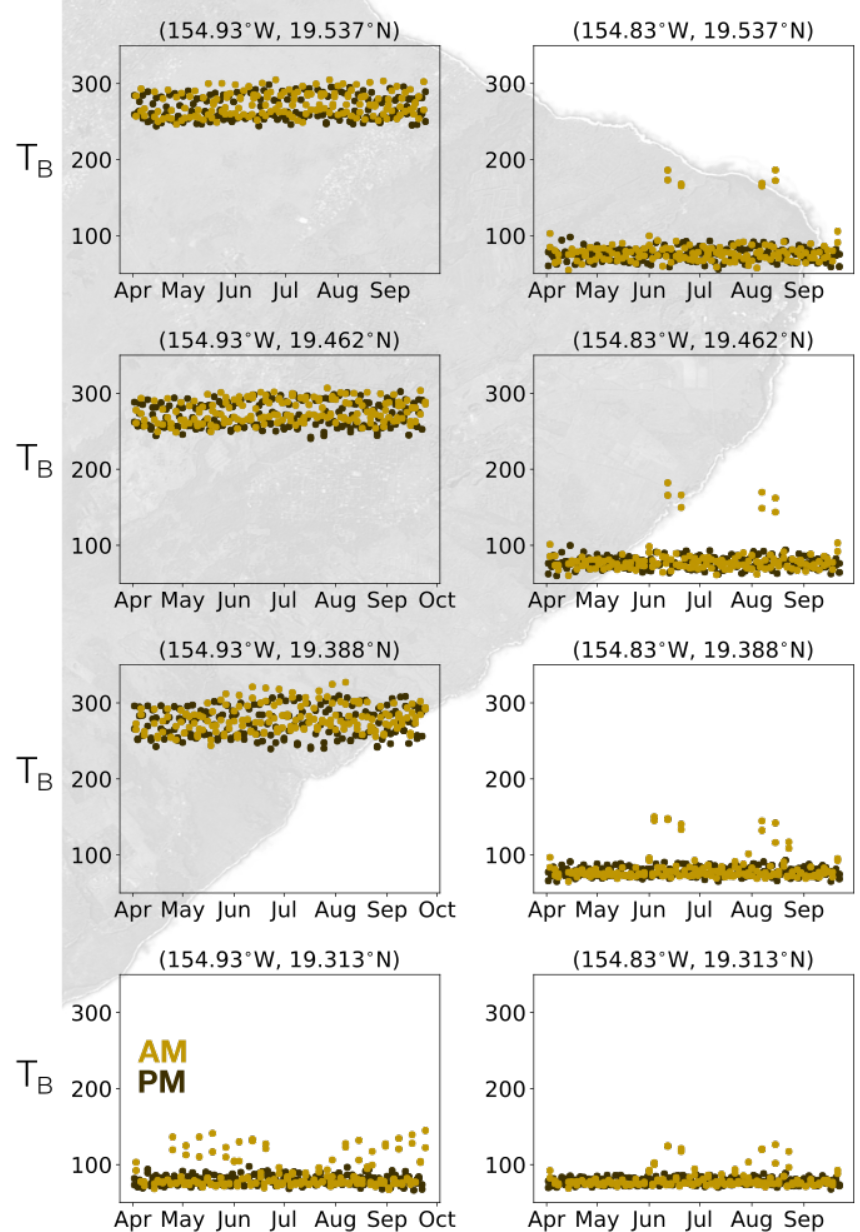
Figure 3. SMAP observations of brightness temperatures of the Kilauea Lower East Rift Zone from April-October 2018. Brightness temperature variations for morning (yellow) and evening (black) track closely, with few anomalies outside the typical variation for land-dominated observations (left column). (SMAP swaths repeat every 8 days, yielding ascending and descending observations every 2 days.) Anomalies in the water-dominated observations (right column) do not correlate with peak flow activity (July). The Landsat image of Figure 2 is shown in grayscale in the background to indicate spatial